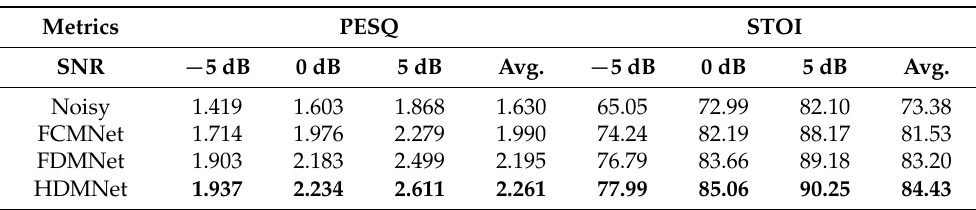
Table 4. Experimental results of different modules under unseen noise conditions for PESQ and STOI. BOLD indicates the best result for each case.